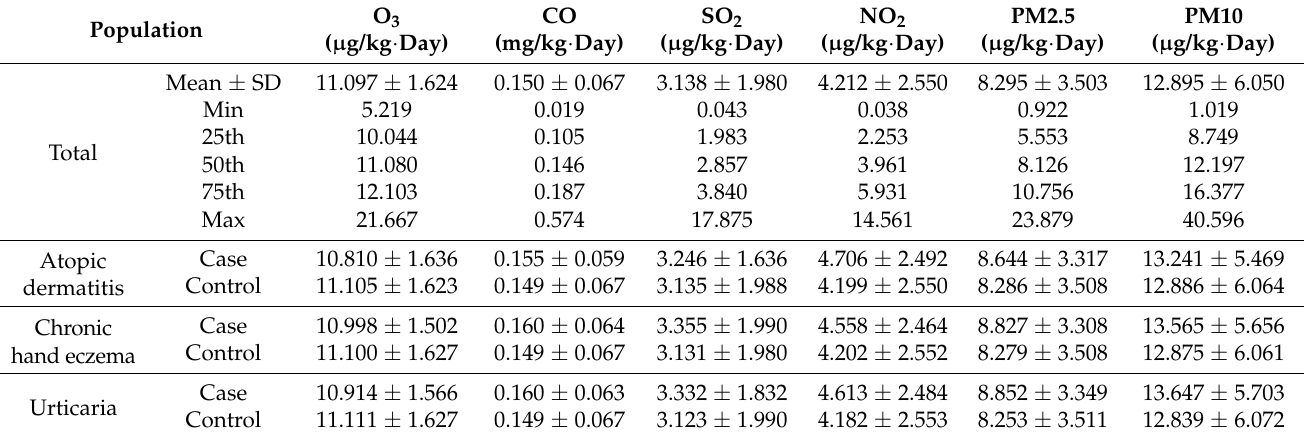
Table 2. Distribution of air pollution exposure for case and control